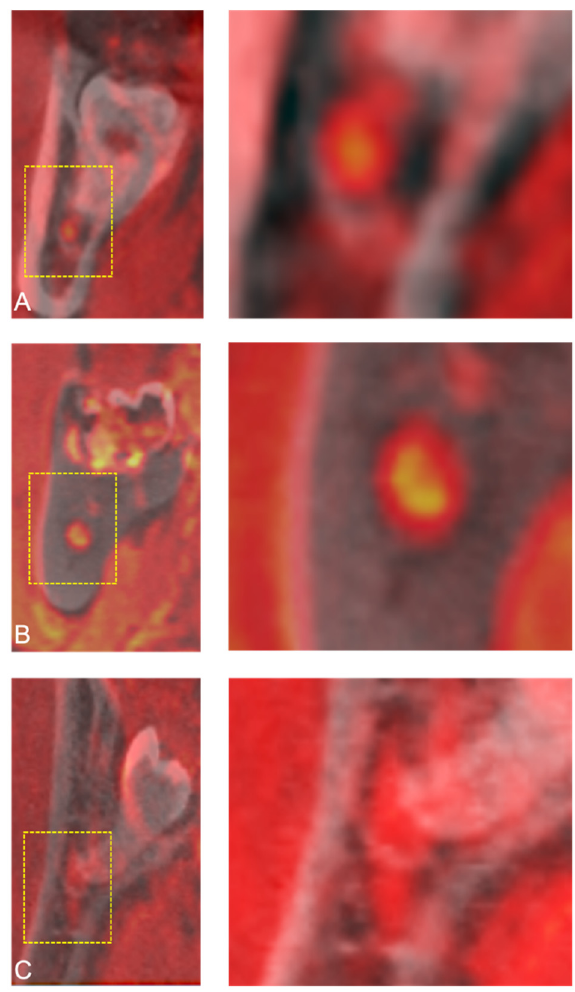
Figure 5. To investigate the occupation of the mandibular canal (MC) by the inferior alveolar nerve’s (IAN) hyperintense signals, the following three patterns were determined according to Deepho et al. [23]: ( A ) small pattern, if the area within the MC was only partially occupied by the presence of IAN MRI signal hyperintensities; ( B ) same pattern, if the area within the MC was occupied by the presence of IAN MRI signal hyperintensities; and ( C ) large pattern, if the IAN was sticking out of the MC area.